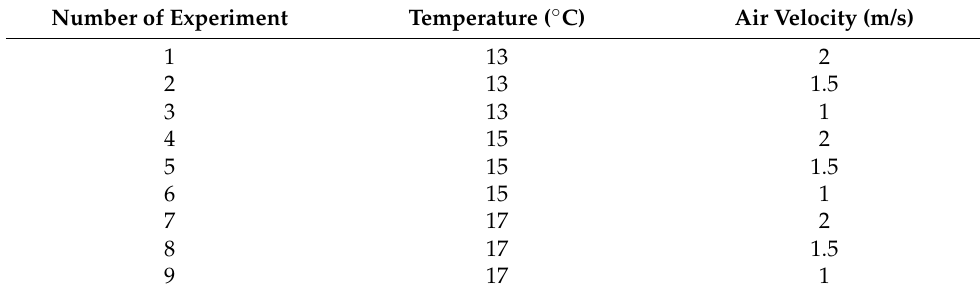
Table 1. Experimental plan